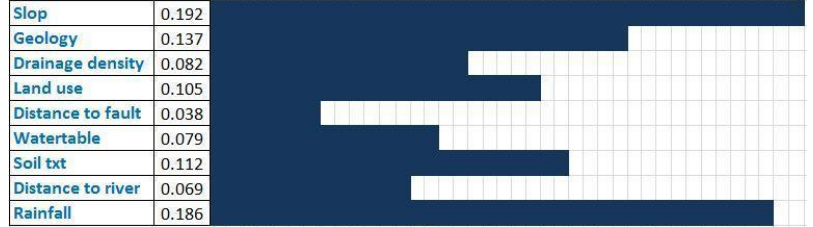
Figure 10. Relative importance of thematic layers.